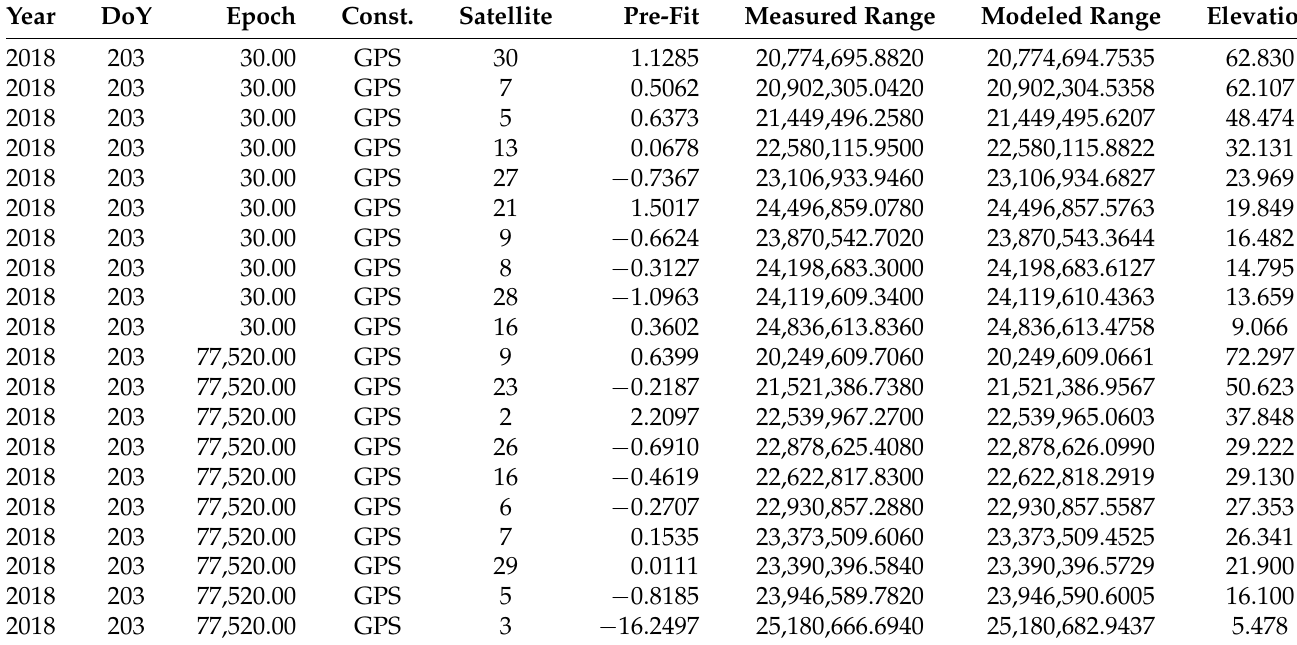
Table 1. Excerpt from the pre-fit data table. Epoch in seconds, pre-fit and ranges in meters, elevation of the satellites in